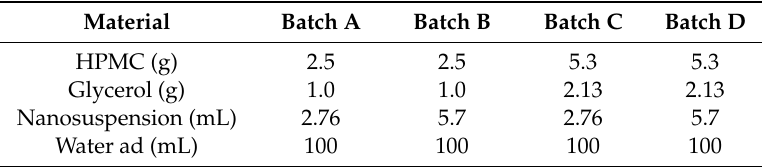
Table 3. Compositions of the drug loaded